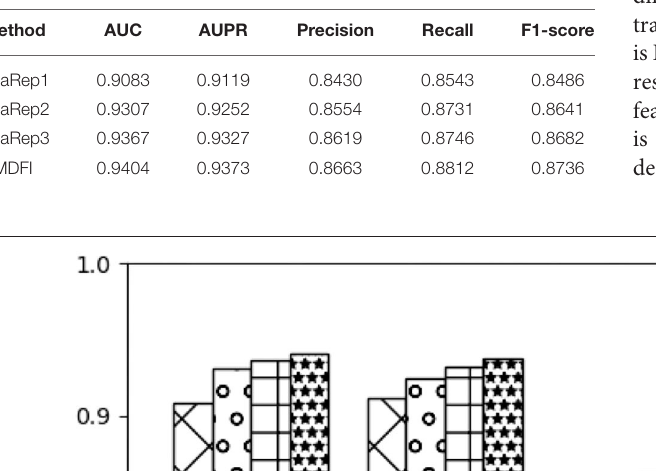
Frontiers in Genetics |